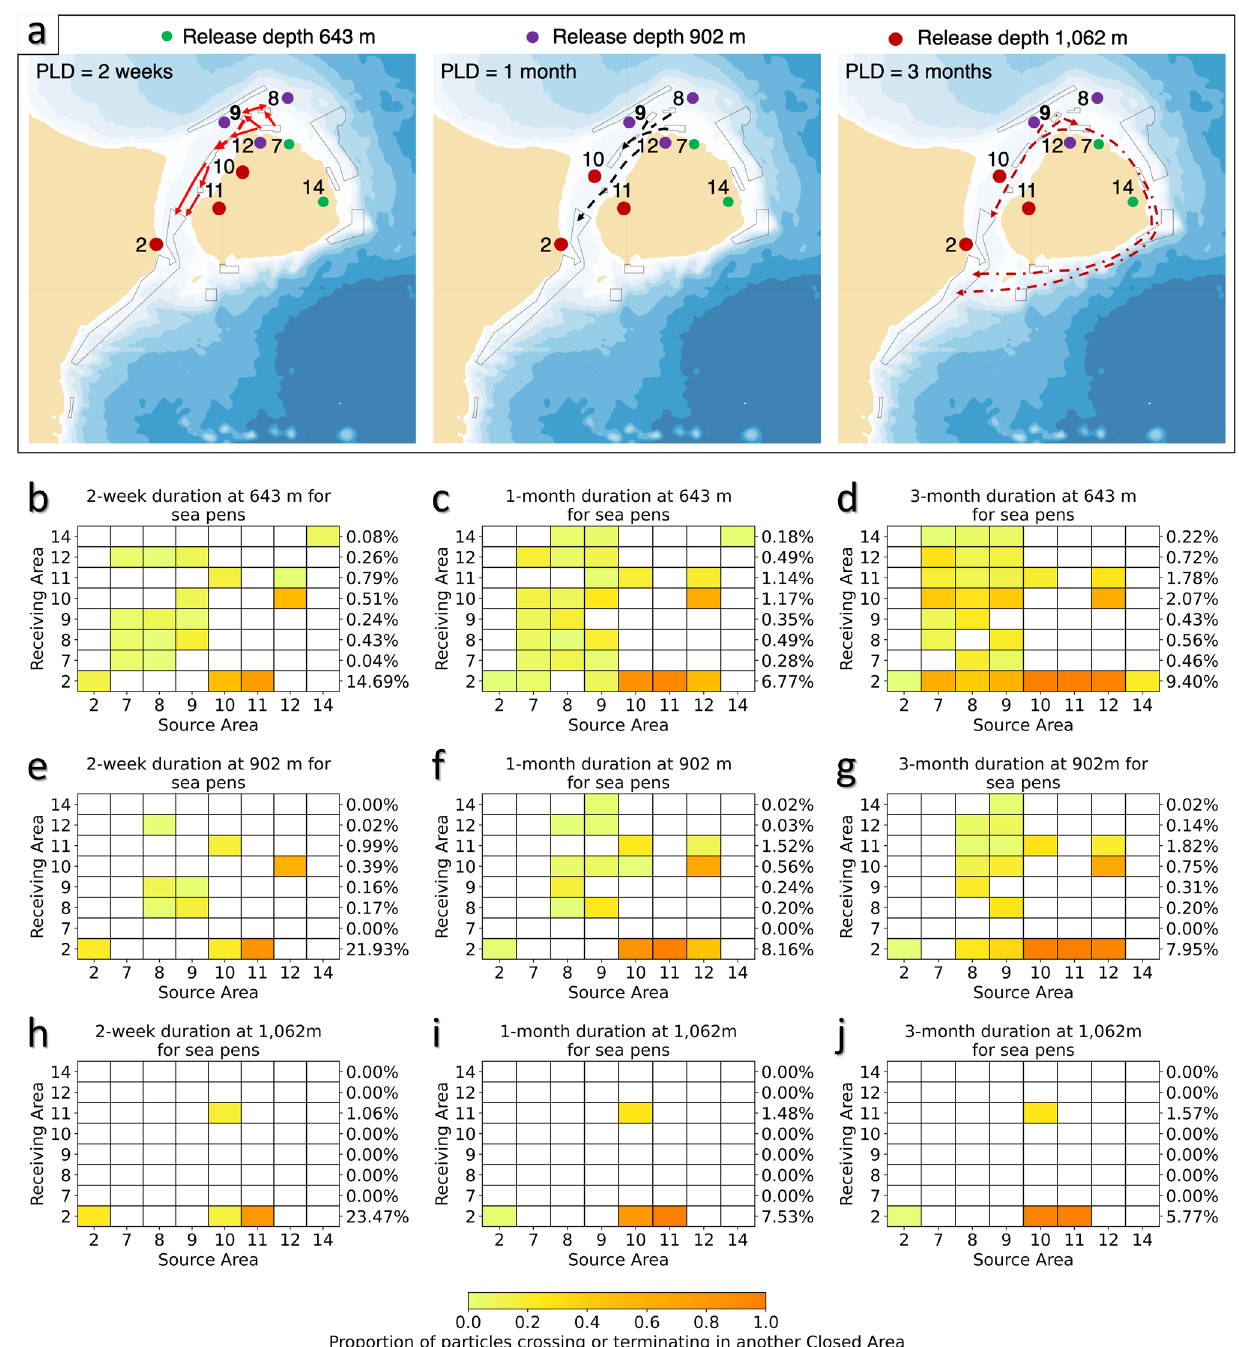
Figure 6. Functional connectivity among areas closed to protect sea pens. ( a ) Forward-tracking connectivity pathways for particles released at 3 depths in each of the 8 areas closed to protect sea pens (Areas 2, 7, 8, 9, 10, 11, 12, 14). Drift durations were 2 weeks, 1 month, and 3 months. The closed circles near the number code of some of the closed areas denotes that particles from this area are only released at this depth due to the depth of the closure, and the line indicates where particles can reach another closed area when released from this depth. The maps were generated using bathymetry and coastline data produced and made publically available by the NOAA National Centers for Environmental Information (NCEI). The ETOPO1 Ice Surface (https:// doi. org/ 10. 7289/ V5C82 76M) arc-minute global relief model of the Earth’s surface (https:// www. ngdc. noaa. gov/ mgg/ global/) was used to generate bathymetry and the Global Self-consistent, Hierarchical, High-resolution Geography Database (GSHHG; https:// www. ngdc. noaa. gov/ mgg/ shore lines/ gshhs. html) was used to produce co-ordinates for a high-resolution coastline and both plotted using Matlab version 9.5 software (https:// www. mathw orks. com) with the M_Map mapping package (version 1.4 m, created by R. Pawlowicz, https:// www. eoas. ubc. ca/ ~rich/ map. html); ( b – j ) The proportion of modeled particles released from each of the 8 areas closed to protect sea pens (Source Areas; Areas 2, 7, 8, 9, 10, 11, 12, 14) and passing over or terminating in another area closed to protect sea pens (Receiving Areas). For each Receiving Area the percentage of the total number of particles released (from all Source Areas) are provided. Those values include particles that crossed, terminated or were retained in the Receiving Area. Particle release depths were 643 m ( b – d ), 902 m ( e – g ) and 1062 m ( h – j ) with drift durations of 2 weeks ( b , e , h ), 1 month ( c , f , i ), and 3 months ( d , g , j